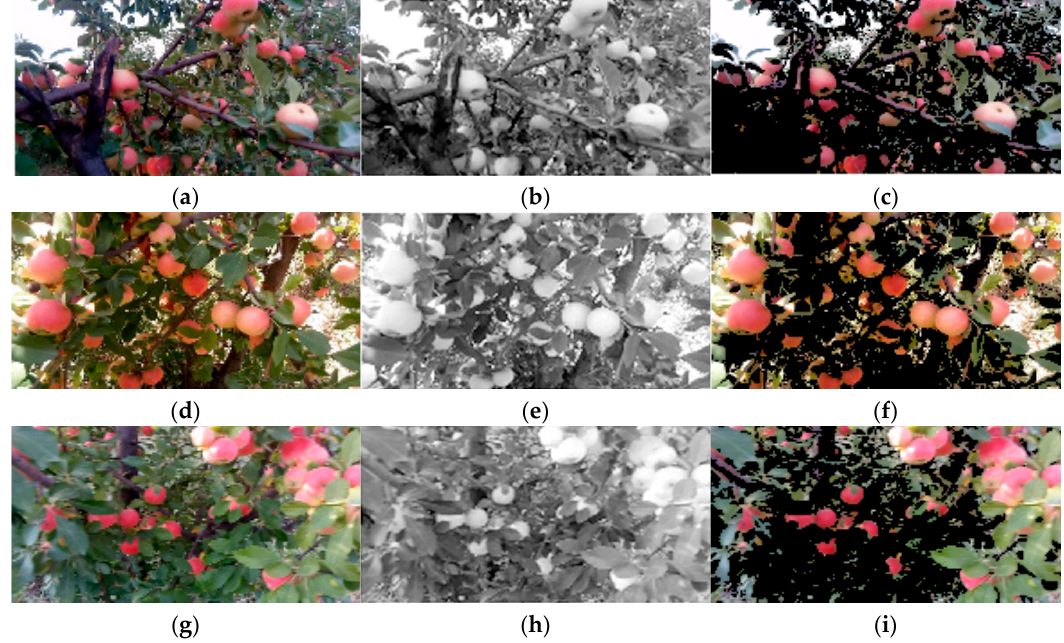
Figure 6. Sample results of applying intensity segmentation on apple images. ( a , d , g ) Three color samples of the videos produced in 796, 1920, and 659 lux. ( b , e , h ) Results from the intensity transformation by selecting the R channel. ( c , f , i ) Segmentation images after applying the threshold.